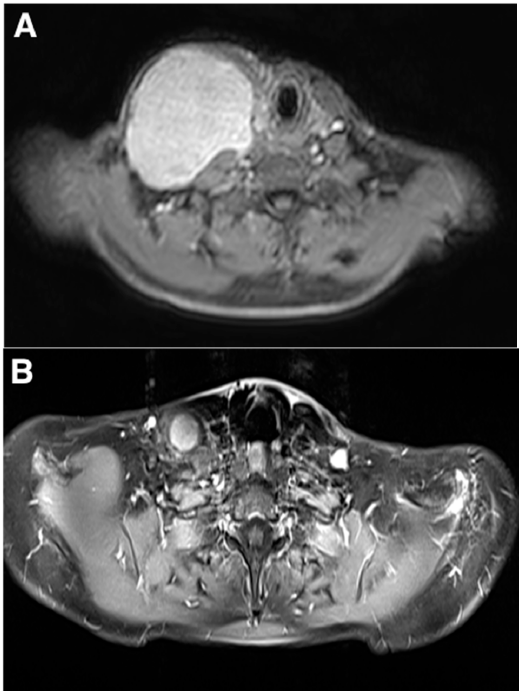
Figure 2. Images from a 39-year-old female with symptomatic lymphatic malformation (LM). ( A ) Pre- treatment T1-weighted post-gadolinium magnetic resonance imaging (MRI) showing an extensive cystic lymphangioma of the right supraclavicular fossa and neck. ( B ) Post-treatment T1-weighted MRI post-gadolinium after two sessions of bleomycin sclerotherapy showing significant volume reduction of the LM (about 80%) with significant discomfort (VAS, 1 versus 6), cosmesis score (1 versus 7) and overall satisfaction (markedly)